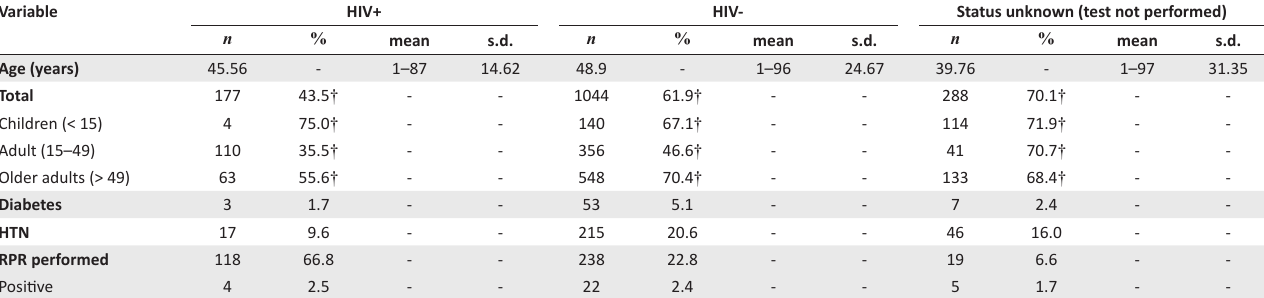
TABLE 1: Patient characteristics. Variable